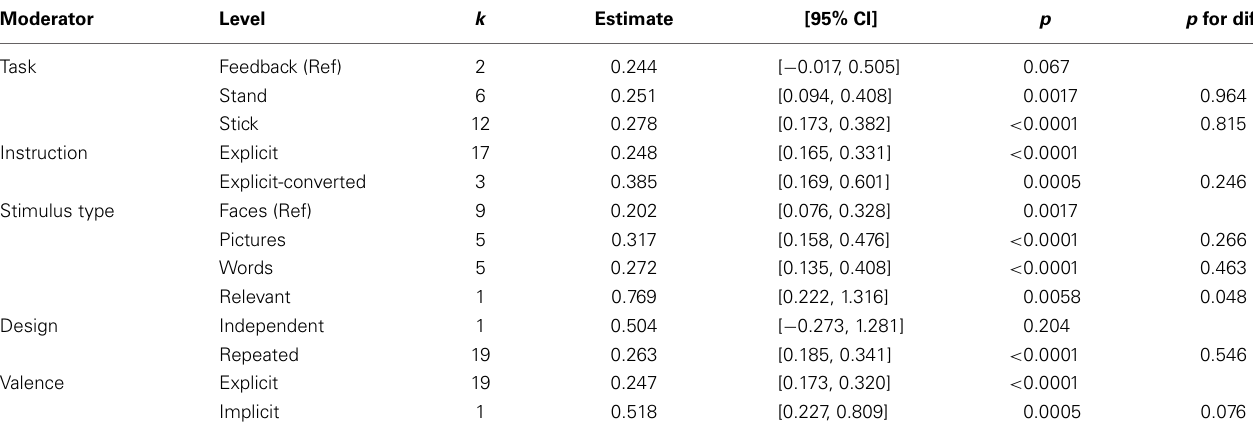
Table 4 | Results of subset analyses of negative affect after exclusion of studies with implicit